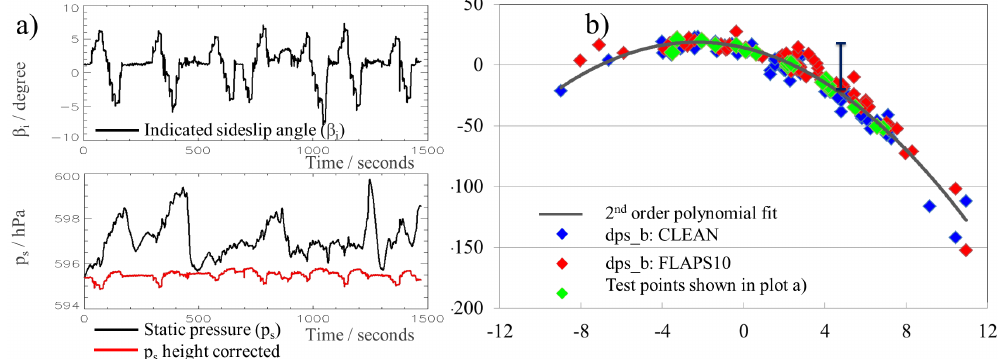
Figure 6. (a) Example of two sequences of a steady sideslip manoeuvre lasting about 500s. The upper panel shows the indicated sideslip angle and the lower panel the corresponding static pressure signal. The raw pressure signal is dominated by the height variation of the aircraft and the β dependency becomes visible when the signal is height corrected using Eq. (12). (b) Difference between the static pressure signal and the reference value calculated with Eq. (12) for 159 test points. Each test point is an average of at least 4s of a constant steady sideslip angle. A second-order polynomial fit is used to correct the static pressure signal from this β influence. The green diamonds correspond to the test points shown in (a) and the black error bar represents the estimated accuracy of the pressure sensor ( σ ∼